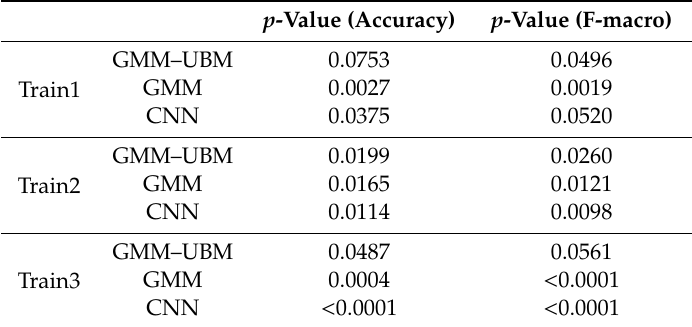
Table 5. p -value between the combined features and MFCC in individual violin recognition.